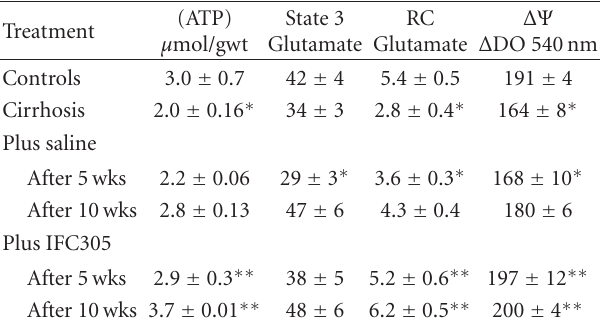
Table 1: E ff ect of IFC305 on mitochondrial parameters in cirrhotic